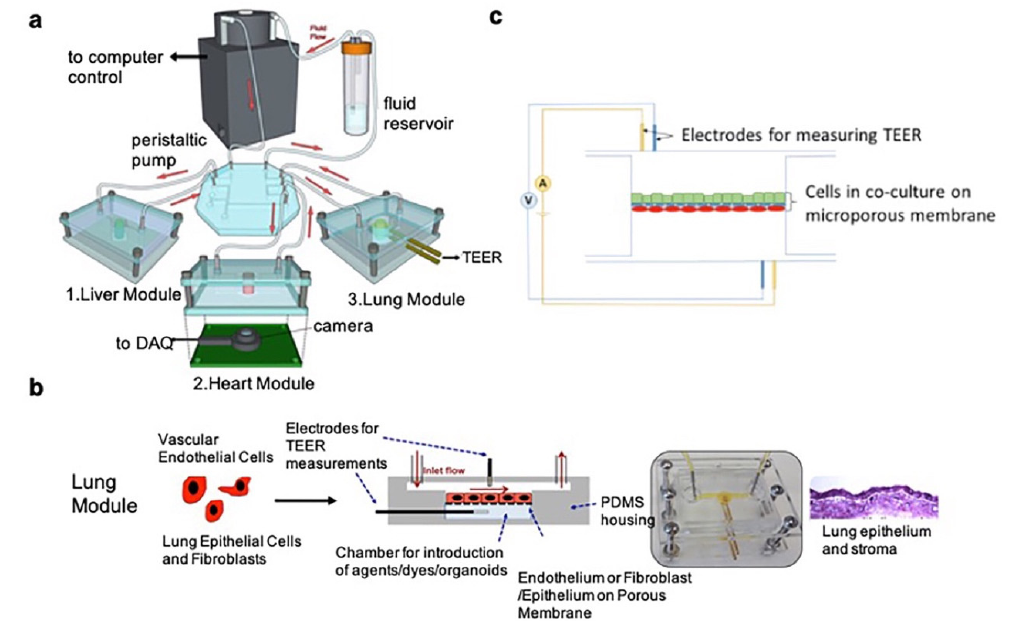
Figure 6. Overall design of the 3-tissue OOC system: ( a ) Illustration of the system. ( b ) Lung modules are formed within microfluidic devices. ( c ) TEER sensors in lung modules are introduced to monitor tissue barrier function over time. Reproduced with permission from [57] .